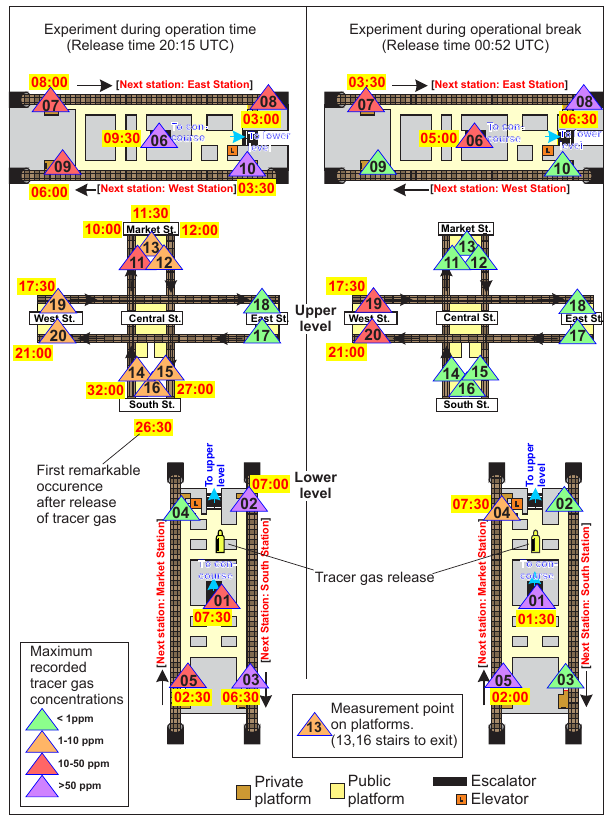
Figure 4. Comparison of tracer gas experiments during traffic times (left) and operational break (right).